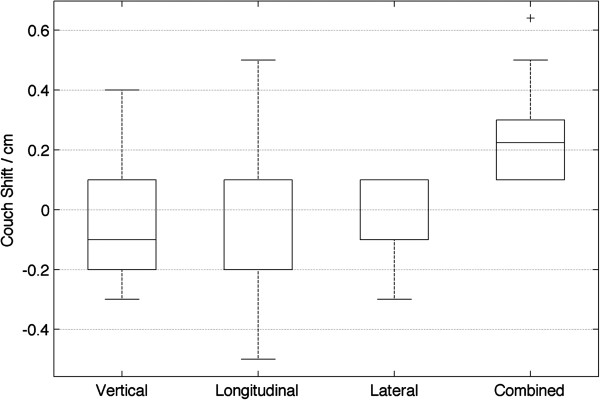
Boxplots of online correction magnitude in vertical, longitudinal and lateral directions, as well as combined length (added in quadrature).